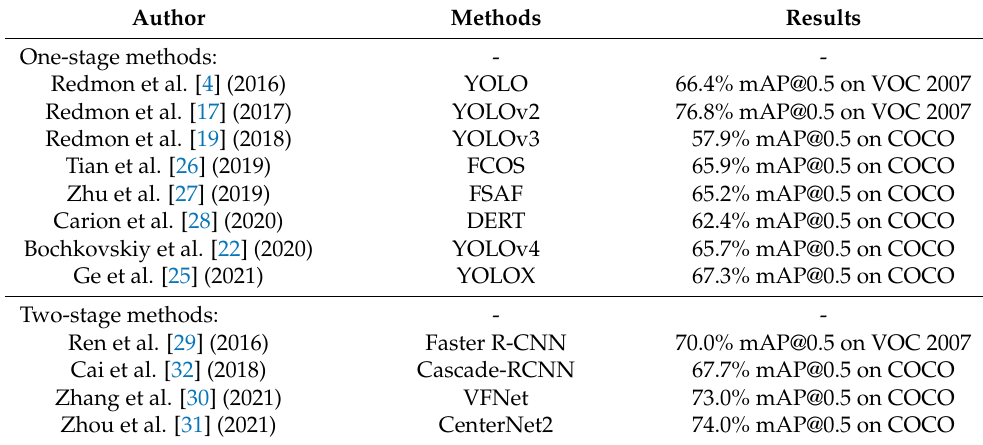
Table 1. Summary of related work on object detection.